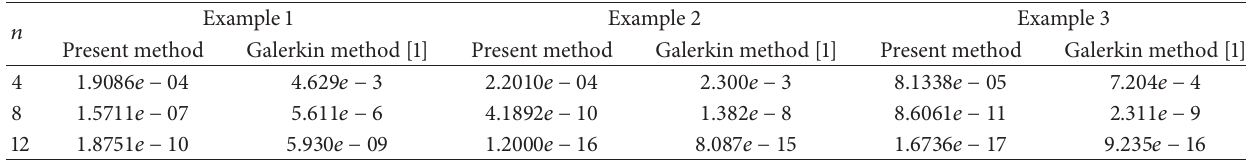
Table 5: Comparison of absolute maximum errors for Examples 1–3 at different 𝑛